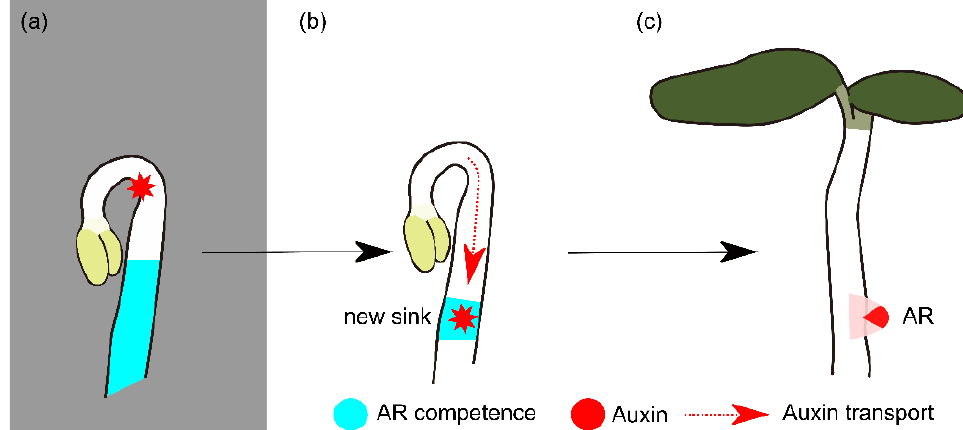
Figure 7. Model for light-induced adventitious root formation. ( a ) In darkness, skotomorphogenetic growth is governed by an auxin maximum that maintains the apical hook, rapid elongation growth and high adventitious rooting competence. ( b ) Light signaling antagonizes auxin activities that control apical hook maintenance and elongation growth by activating auxin transport and dampening auxin signaling, resulting in the formation of a new auxin sink at the site of AR initiation. ( c ) Photomorphogenesis is complete. The apical hook has opened, cotyledons are expanded and green, and the adventitious roots develop further. At this point the competence for AR formation is strongly reduced, and no new ARs are initiated.